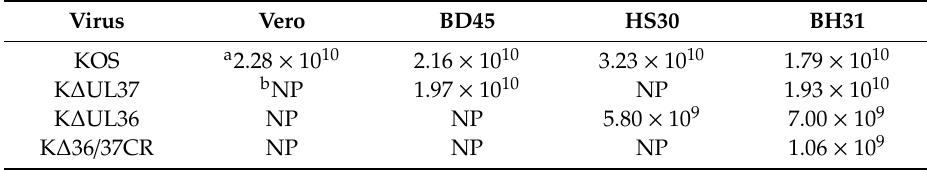
Table 1. Plating e ffi ciency of wild-type HSV-1 strain KOS, K ∆ UL37, K ∆ UL36, and K ∆ 36 / 37CR on Vero, BD45, HS30, and BH31